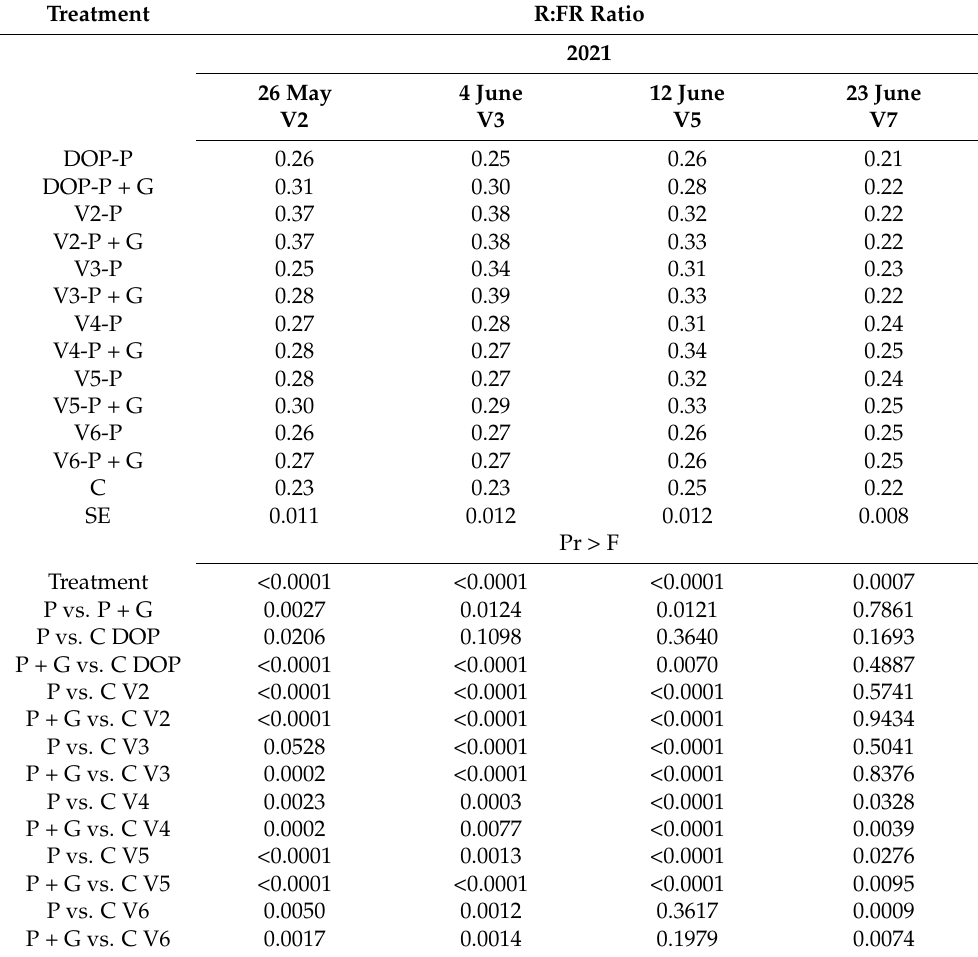
Table 3. Reflected R:FR ratio above perennial groundcover at the Sorenson Research Farm in 2021.